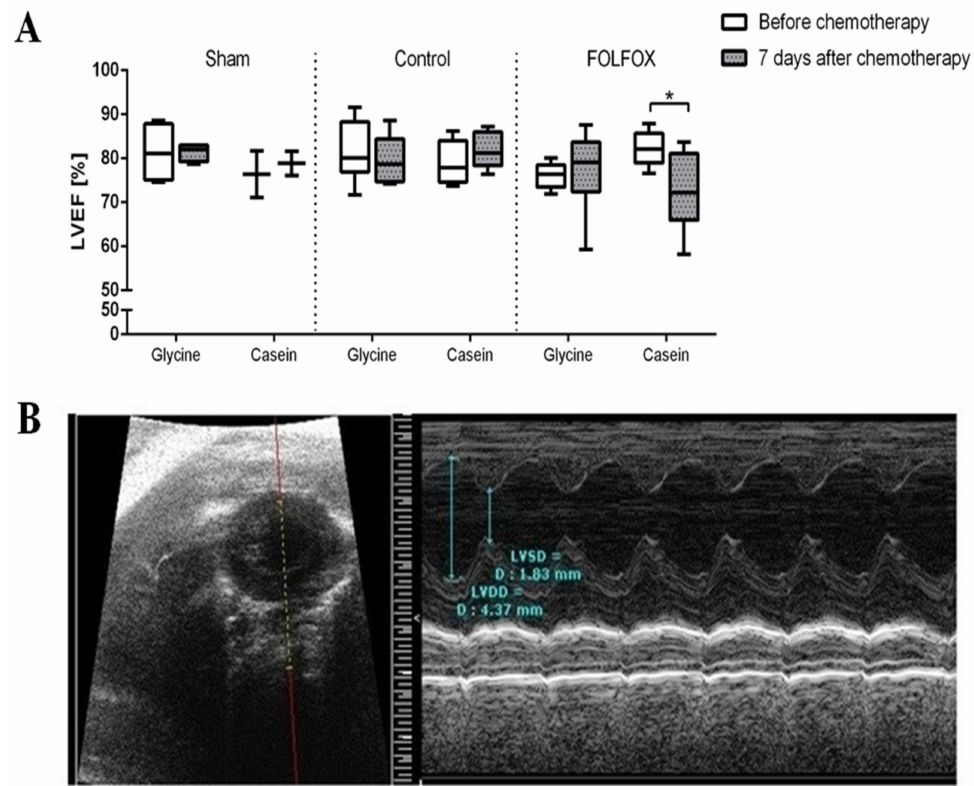
Figure 4. Left ventricle ejection fraction (LVEF) before and after chemotherapy in di ff erent diet groups. ( A ) Left ventricle ejection fraction (LVEF) before and after chemotherapy in the study groups; * p < 0.05. ( B ) Representative view from heart ultrasound. Left: Heart in parasternal short-axis view; Right: M-mode, left ventricular internal